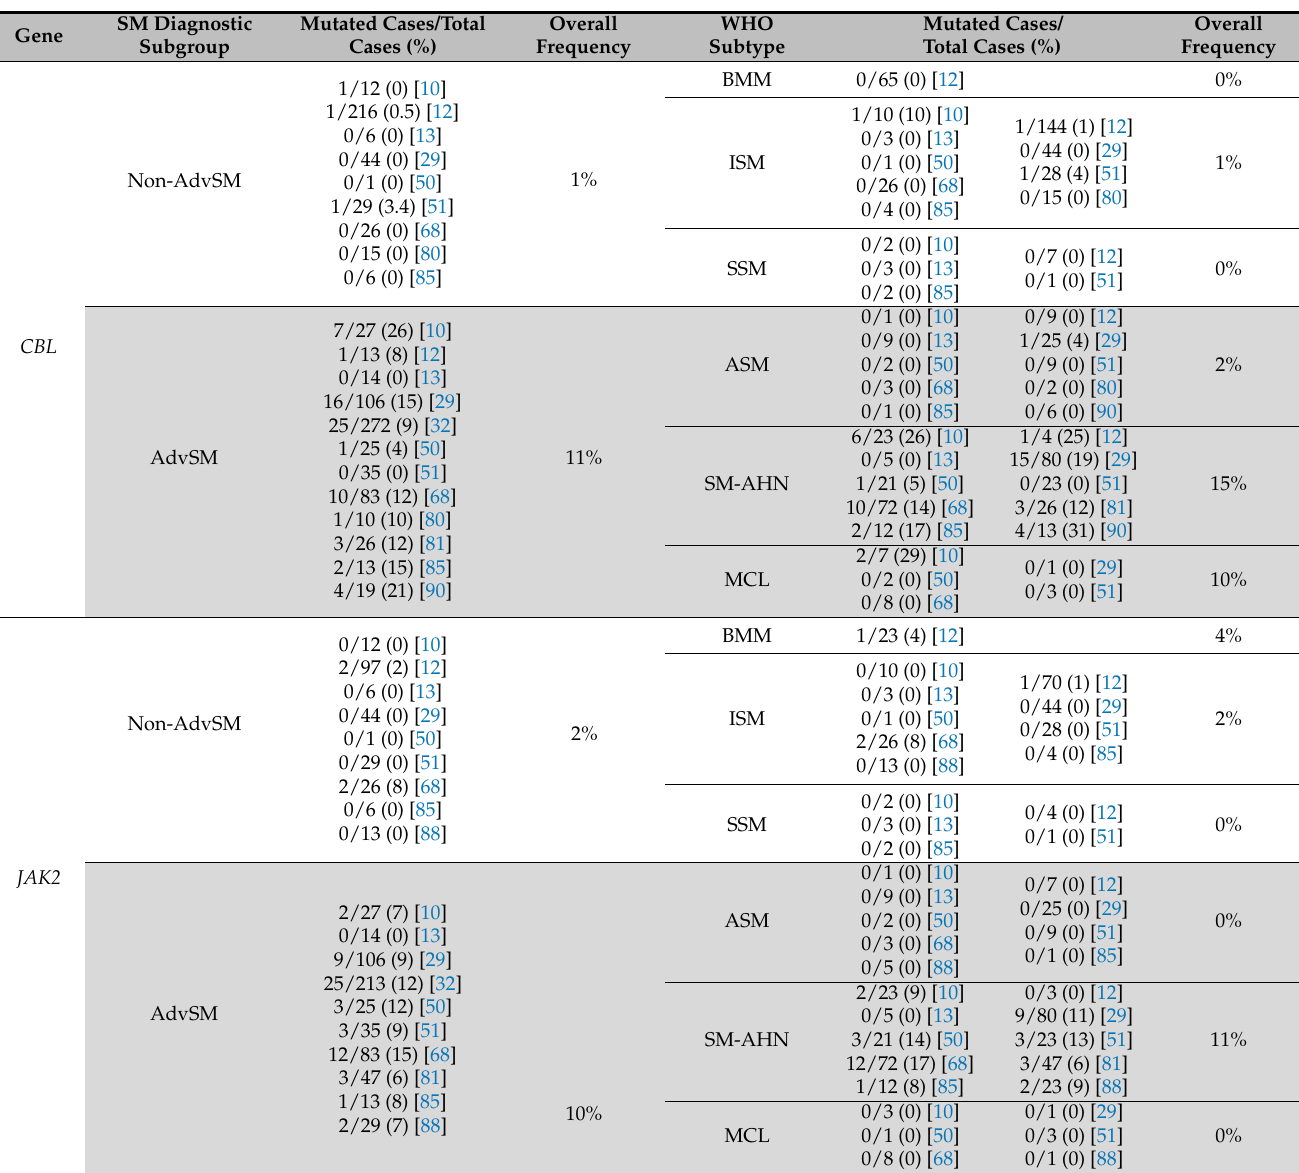
Table 3. Frequency of mutations in genes affecting transcription factors and signalling pathways found to be recurrently altered in systemic